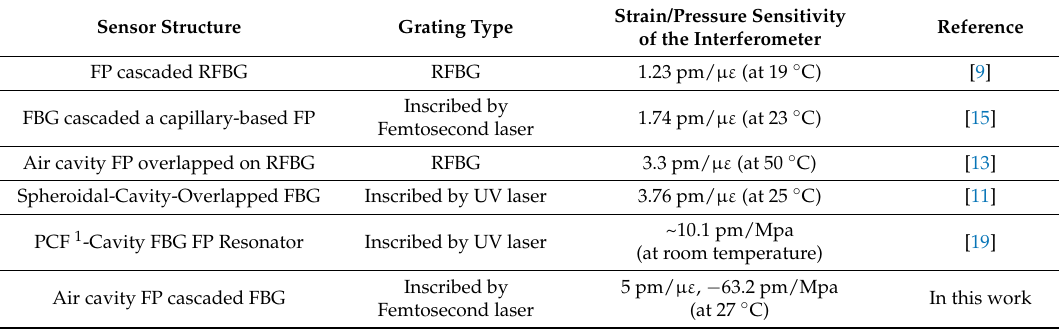
Figure 7. ( a ) Pressure responses of the sensor at room temperature; ( b ) stability of the FP pressure sensor. Table 2. The performance of different combination structures of FP and fiber Table 2. The performance of different combination structures of FP and fiber grating.